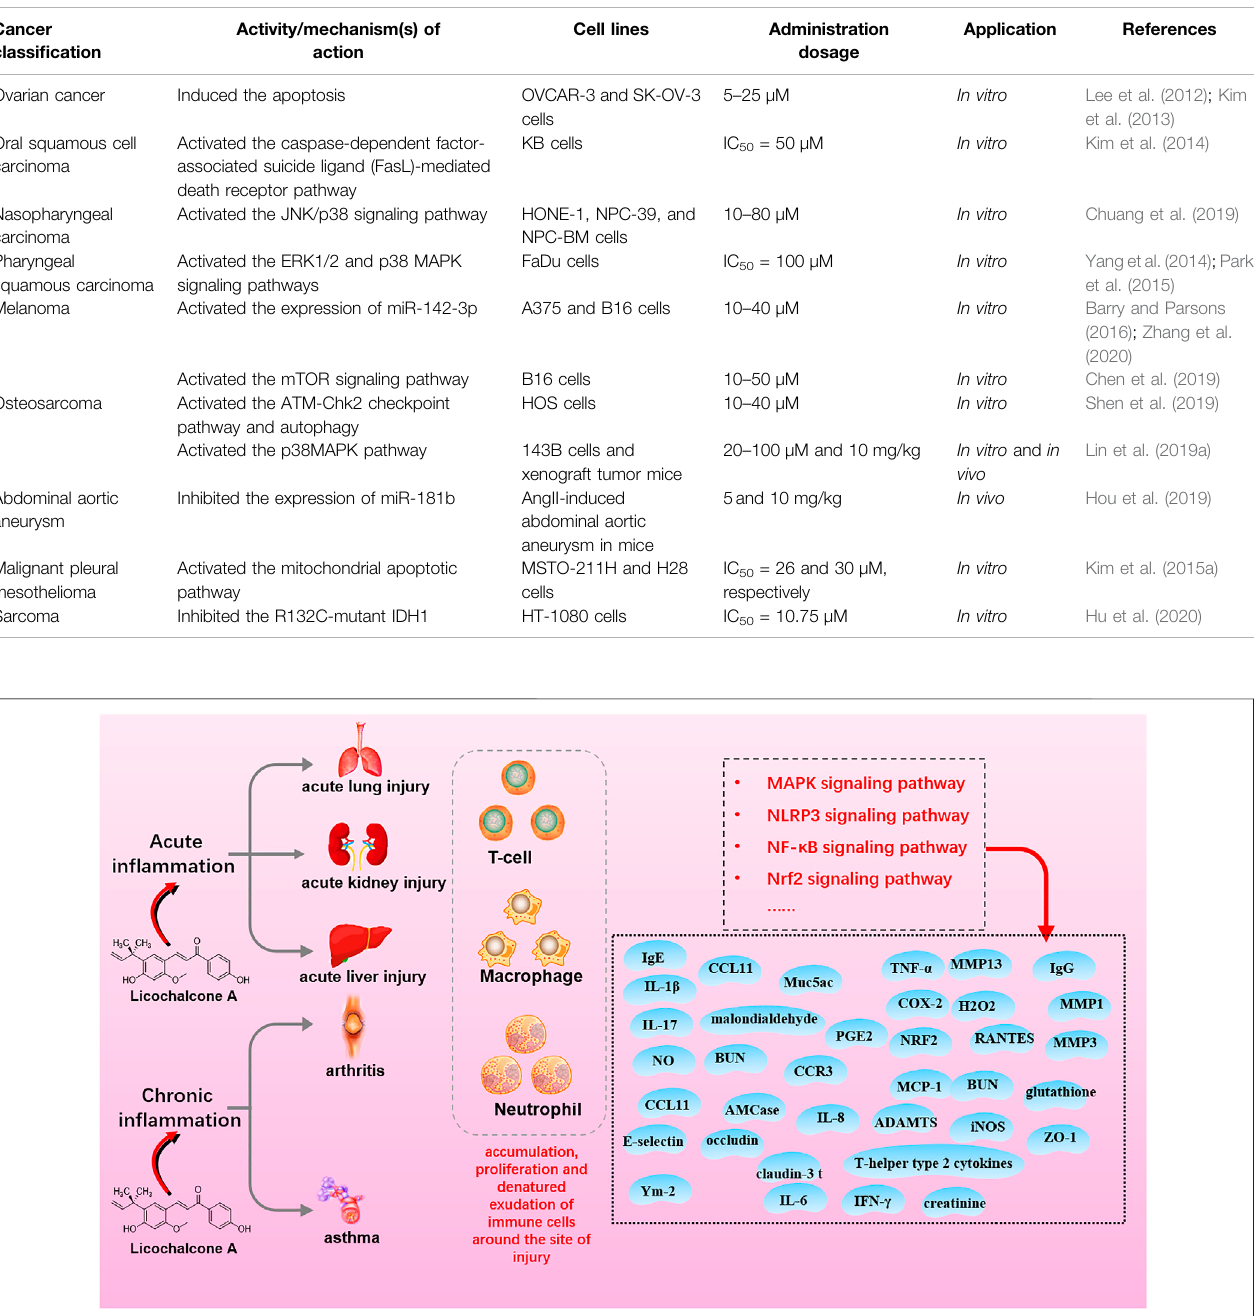
Frontiers in Pharmacology |